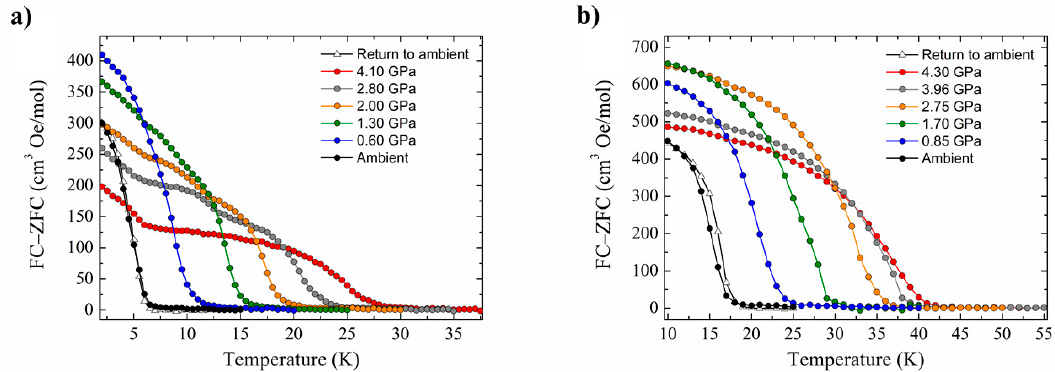
Figure 21. Pressure dependence of the ordering temperature of ( a ) compound 14 and ( b ) compound 15